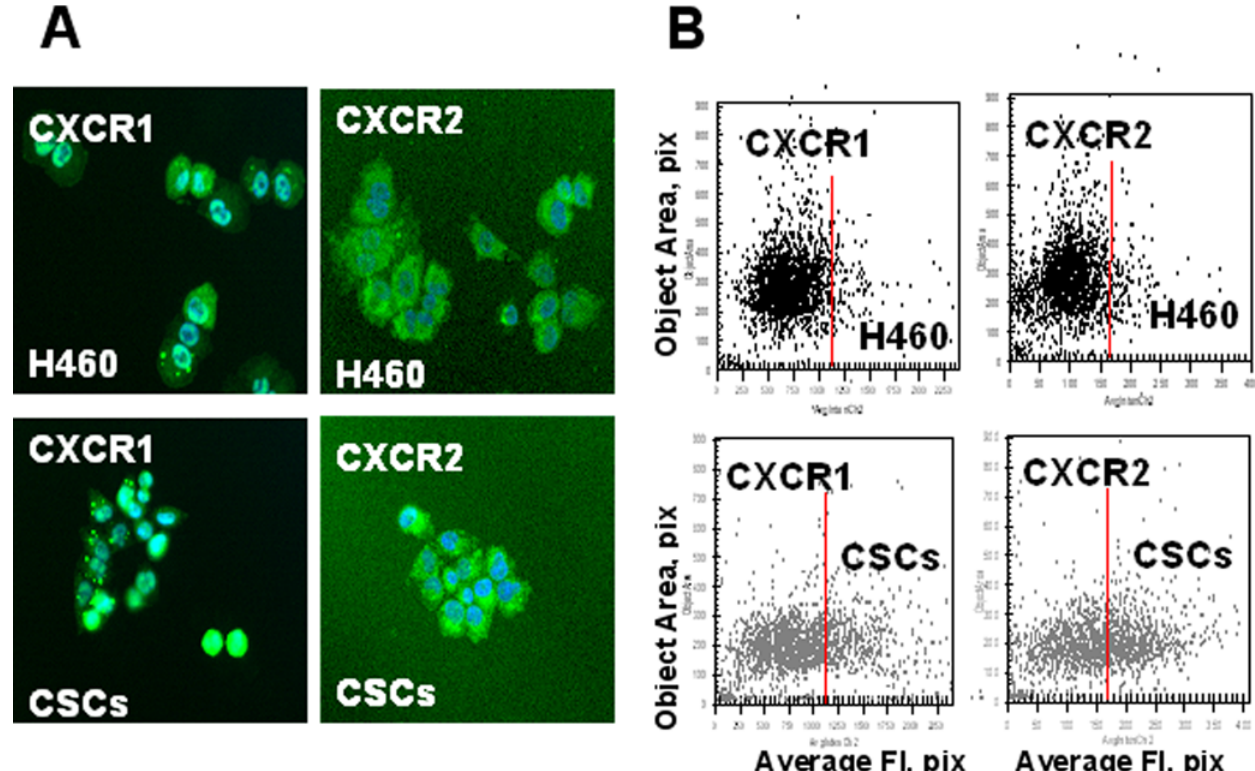
Figure 9. Increased expression of chemokine receptors (CXCR1, 2) in lung CSCs. A, Immunofluorescent images of CXCR1 and CXCR2 in H460 and CS cells. H460 cells and lung CSCs dissociated from spheres were plated into 96-well plates precoated with Collagen IV and cultured 8 h. Then adherent cells were incubated with antibodies against CXCR1 and CXCR2 and with secondary antibodies conjugated with Alexa Fluor H 488 and stained with Hoechst33342. Images were acquired using the Cellomics ArrayScan HCS Reader (20X objective) and analyzed using the Target Activation BioApplication Software Module. B, Fluorescence intensity (pix) of CXCR1 and CXCR2 plotted against object area.